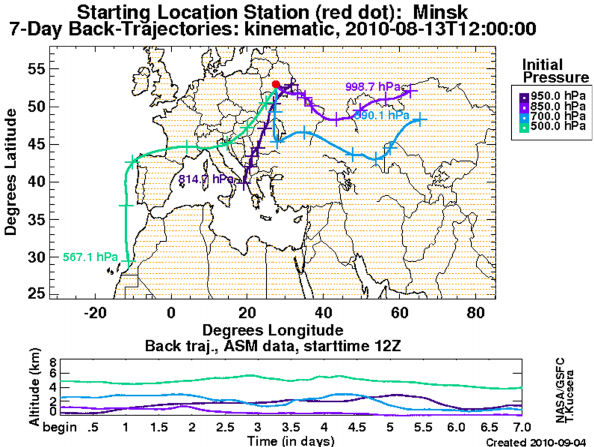
Fig. 13. Air mass back trajectories for the Minsk measurement site on 13 August 2010.